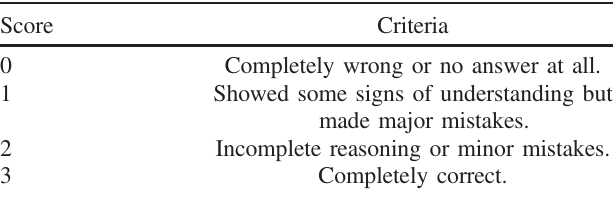
TABLE II. Rubrics for experiment 1 post-test problems.